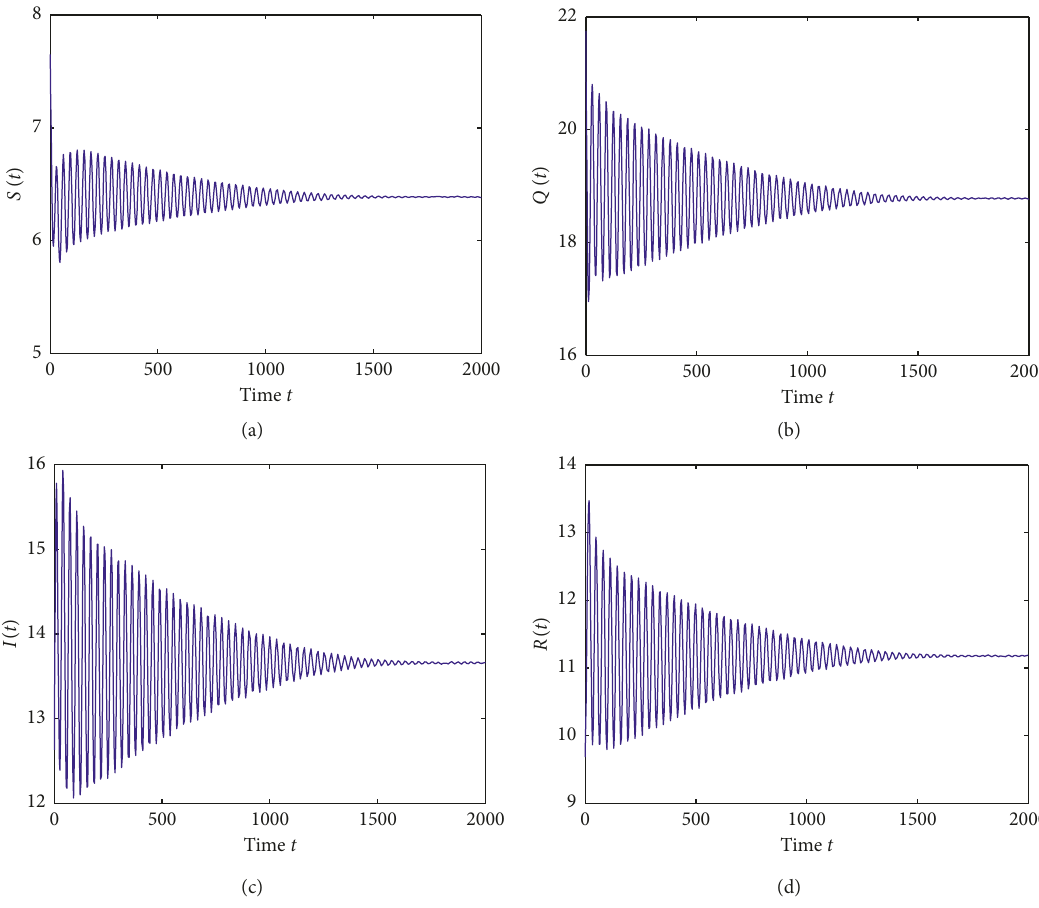
Figure 8: Waveform plots of system (65) with τ